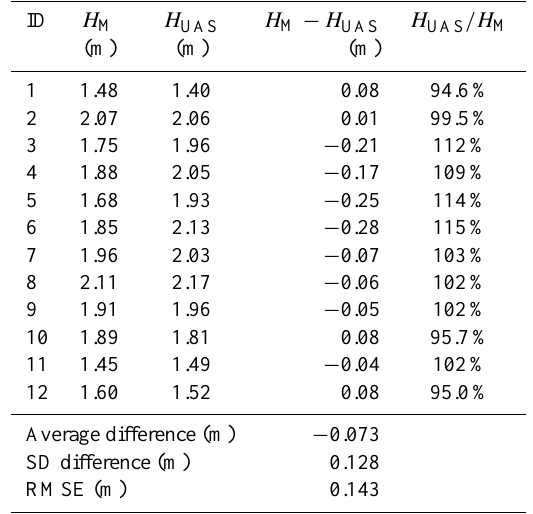
Table 1. Comparison of manual ( H M ) and UAS ( H UAS ) snow depth measurements.